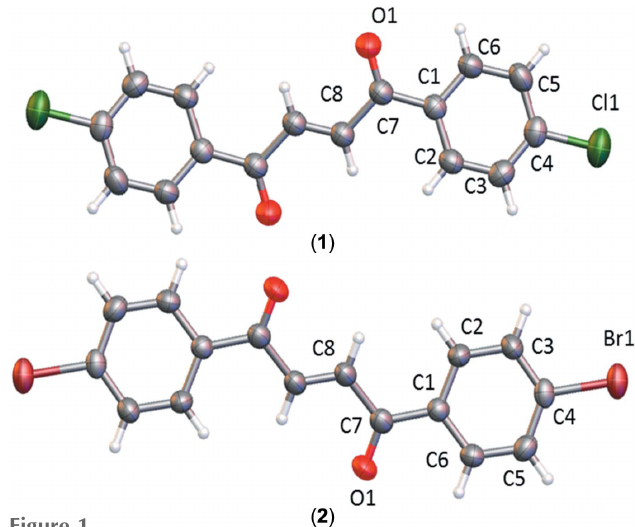
Figure 1 Molecular conformation and atom-numbering scheme of ( 1 ) (top) and ( 2 ) (bottom). The non-labeled atoms are generated by symmetry operation ( (cid:4) x , 1 (cid:4) y , 1 (cid:4) z ) for ( 1 ) and (1 (cid:4) x , (cid:4) y ,1 (cid:4) z ) for ( 2 ). Non-hydrogen atoms are shown as 50% probability displacement